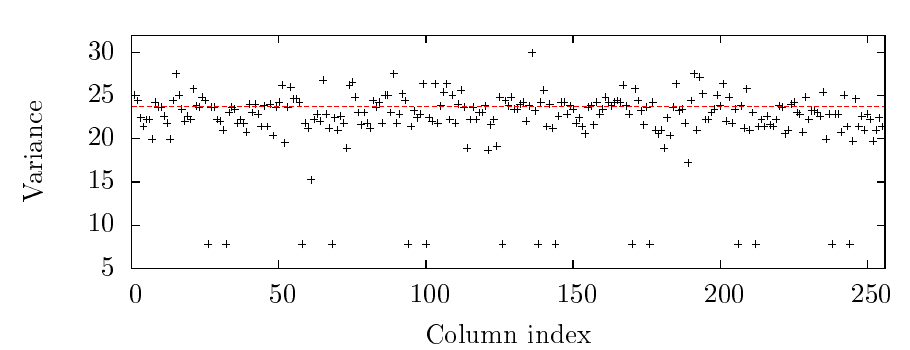
Figure 3: The variance of the columns of the LAT (absolute values) of 𝜋 (Streebog). The expected variance is represented with a red dashed line.